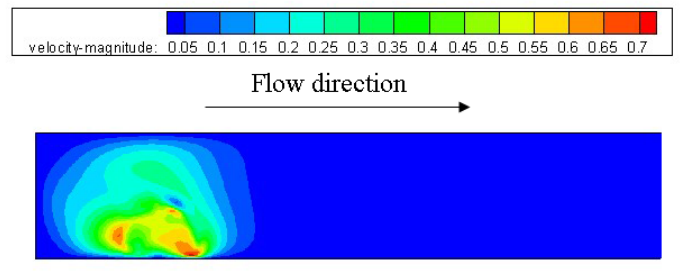
Figure 10. Velocity contour in the channel with varied contact angle from 145° to 105° ( t = 1 ms).